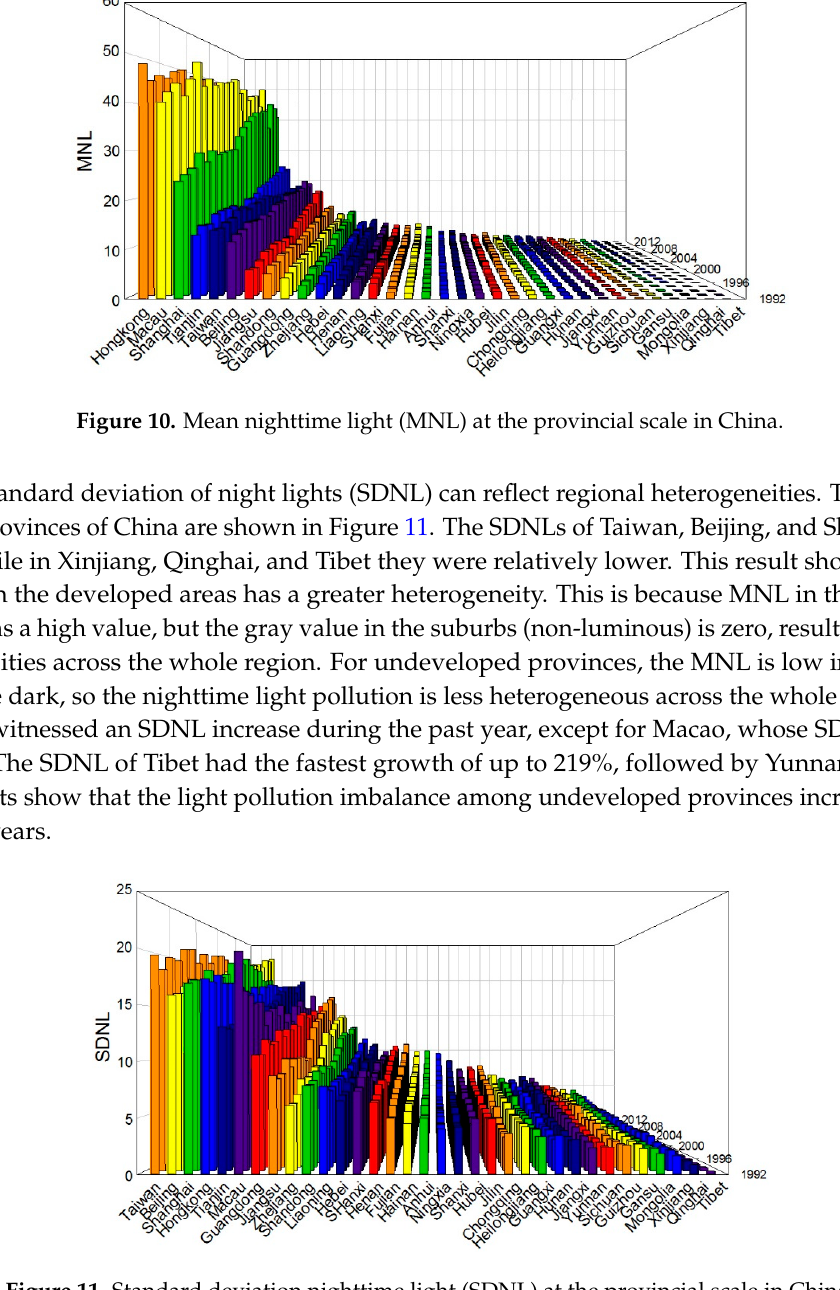
Figure 11. Standard deviation nighttime light (SDNL) at the provincial scale in China.